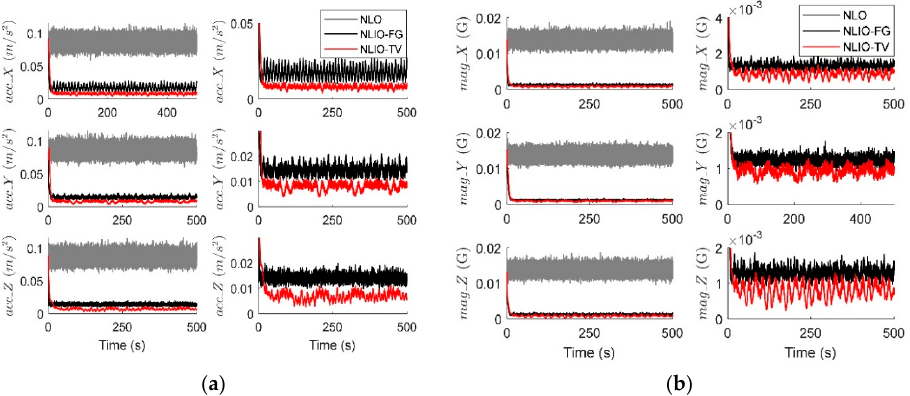
Figure 6. Averaged absolute vector measurement estimation errors over 100 simulations for Case 2. ( a ) Accelerometer measurement estimation errors evaluated by the auxiliary observers of the NLO and NLIOs. The first column: comparisons of NLO, NLIO-FG, and NLIO-TV. The second column: comparisons of NLIO-FG and NLIO-TV. ( b ) Magnetometer measurement estimation errors evaluated by the auxiliary observers of the NLO and NLIOs. The first column: comparisons of NLO, NLIO-FG, and NLIO-TV. The second column: comparisons of NLIO-FG and NLIO-TV.